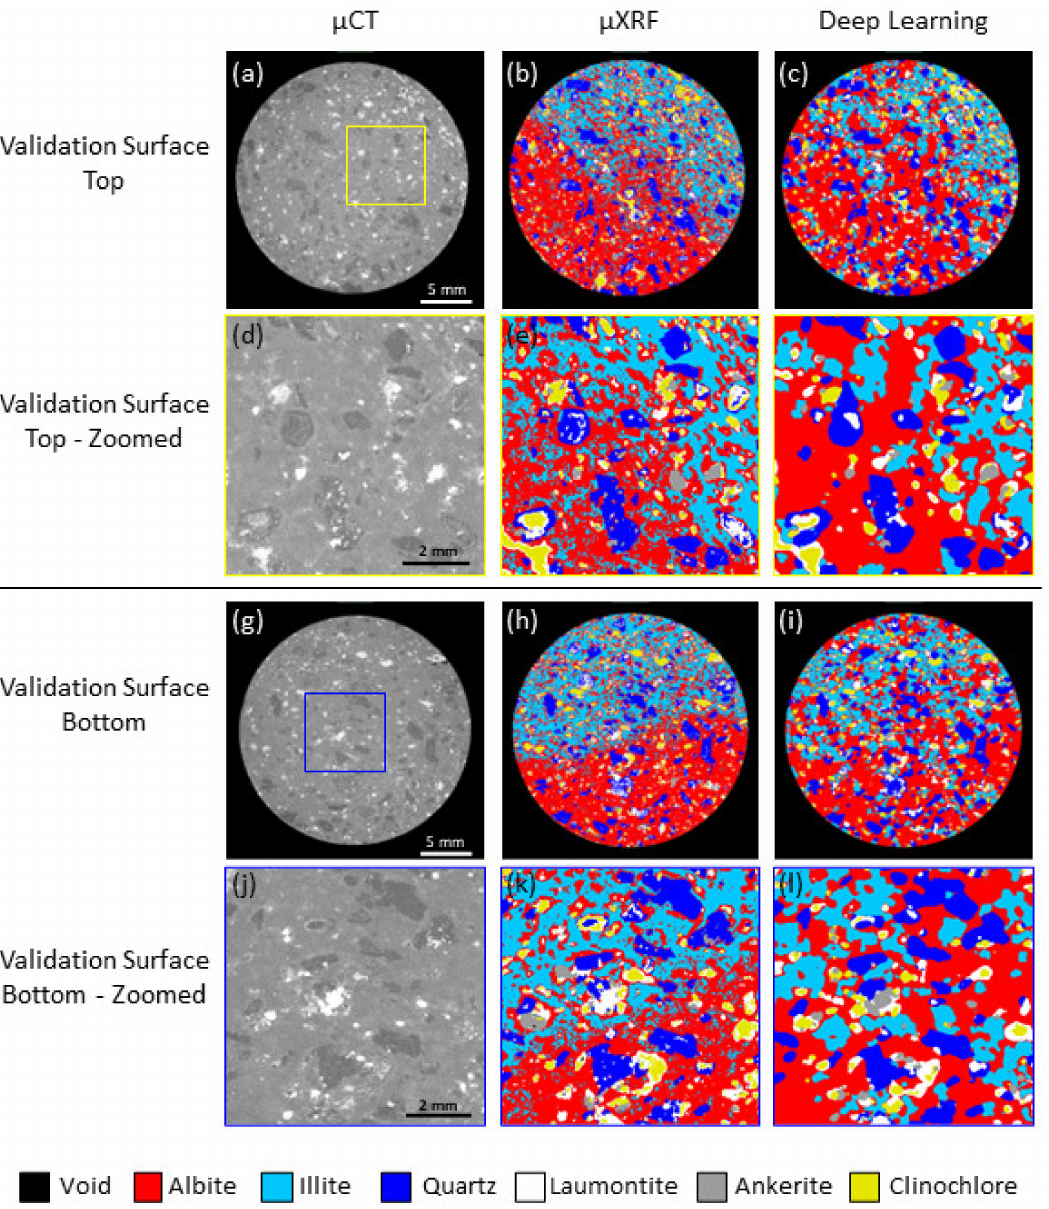
Figure 8. Validation data from the top surface for ( a ) µ CT data; ( b ) µ XRF from K-means clustering; ( c ) deep learning segmentation; ( d – f ) zoomed areas as defined by the yellow inset box, respectively. The validation data from bottom surface is shown for ( g ) µ CT data; ( h ) µ XRF from K-means clustering; ( i ) deep learning segmentation; ( j – l ) zoomed areas as defined by the blue inset box,